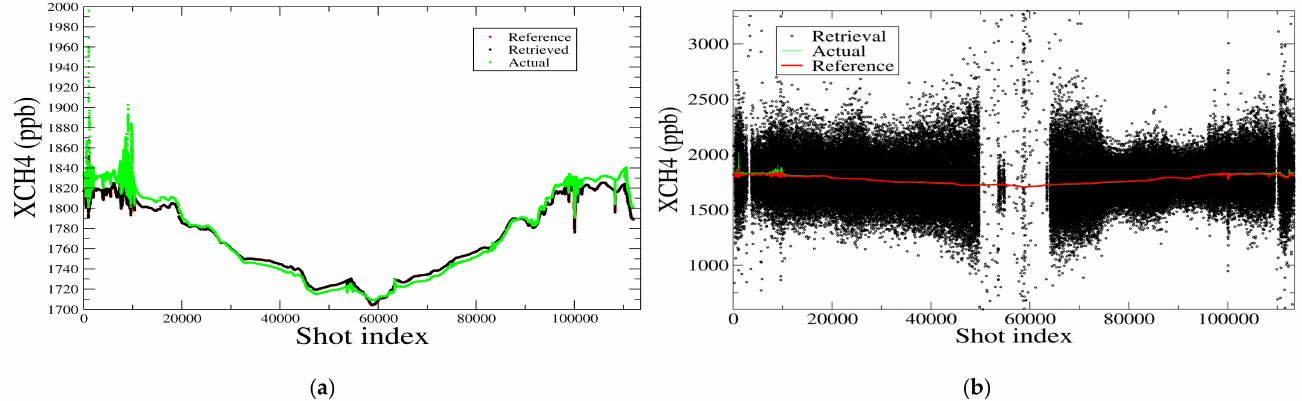
Figure 24. For a complete orbit, the actual (or full column average) XCH 4 in green, the XCH 4 reference in red and the retrieved XCH 4 in black. ( a ) experiment without noise. (The curve in red for the XCH 4 reference is not visible because everywhere the retrieved methane is very close to its reference value); ( b ) with instrumental